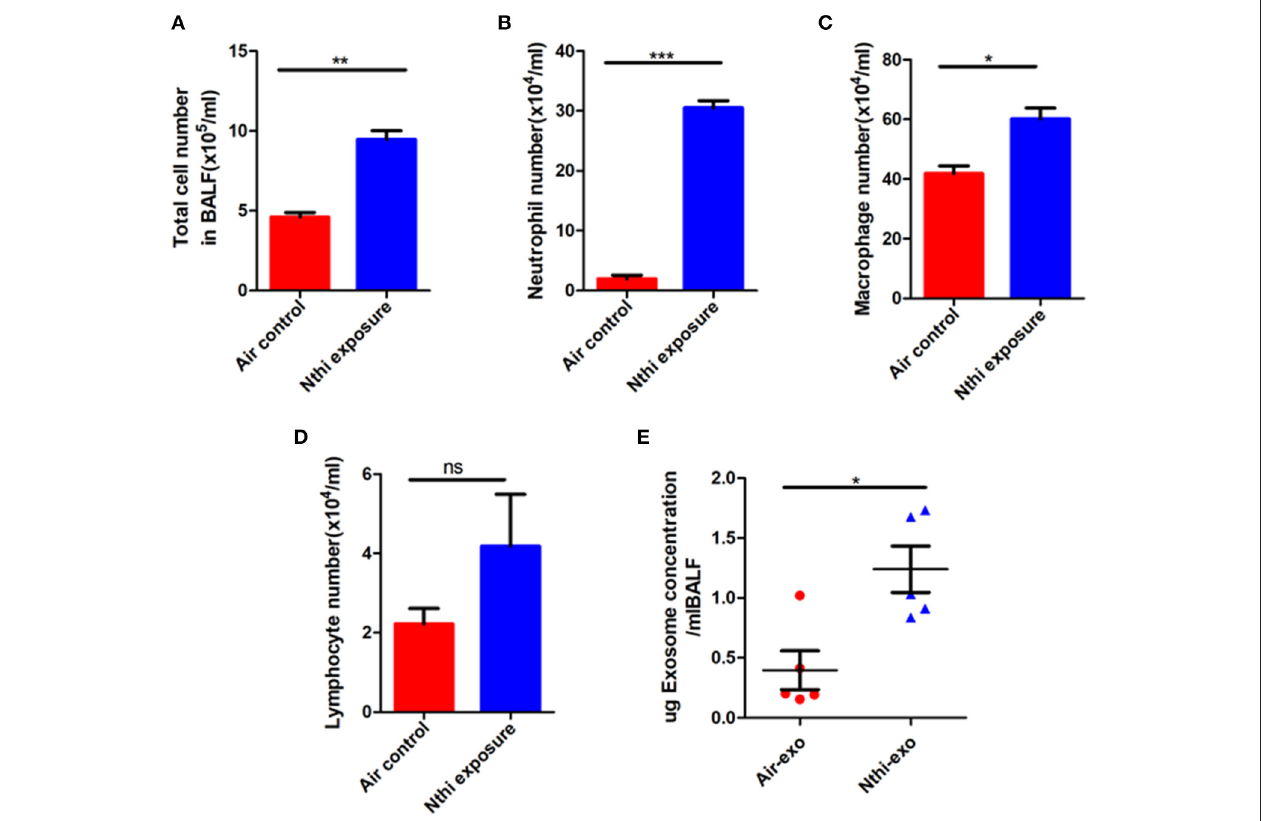
FIGURE 2 | Analysis of the cells and exosomal protein concentration in the bronchoalveolar lavage fluid (BALF). (A) Total cell numbers in the BALF of mice exposed to NTHi lysate or air. (B–D) The composition of cells was evaluated through cytospin preparations. The number of (B) neutrophils, (C) macrophages, and (D) lymphocytes in the BALF of mice exposed to NTHi lysate or air. (E) Concentration of exosomal protein ( µ g) from BALF of NTHi- and air-induced mice. Results are means ± SEM ( n = 5), * P < 0.05, ** P < 0.01, *** P <